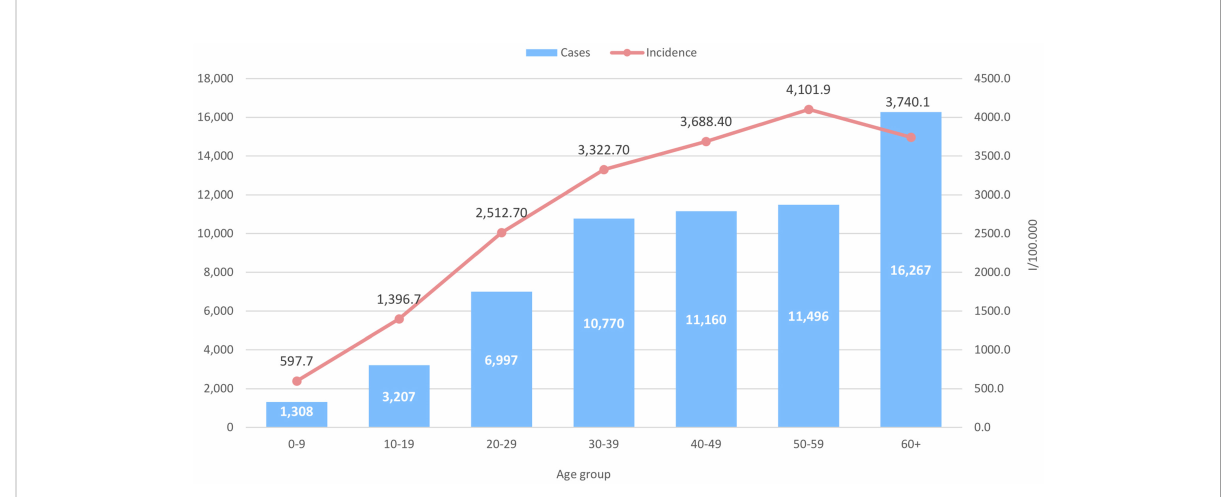
FIGURE 2 Number of SARS-CoV-2 cases in the period January 2020 – December 2021 and SARS-CoV-2 incidence by age